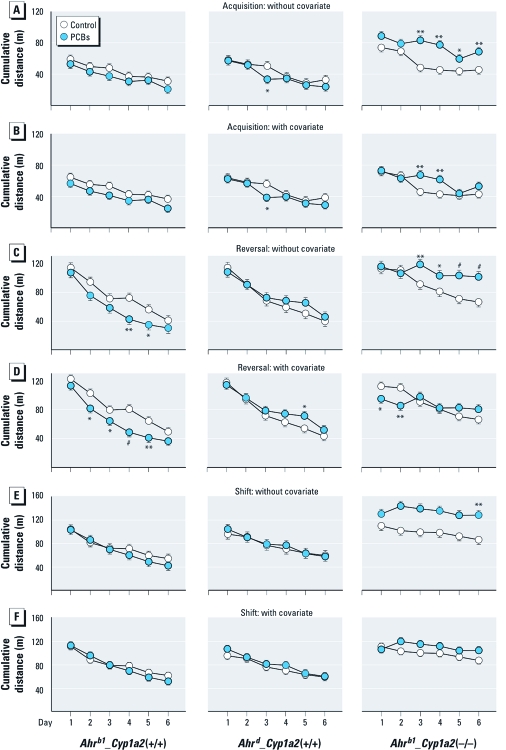
Results of MWM (hidden) test presented as cumulative distance to the platform (mean ± SE). During each phase there were genotype × treatment effects on speed (all p < 0.01); therefore, data were analyzed using without (A,C,E) and with (B,D,F) speed as covariates. (A and B) Acquisition (southwest platform). (C and D) Reversal (northeast platform). (E and F) Shift (northwest platform). See Supplemental Material, Table S2 (http://dx.doi.org/10.1289/ehp.1002965). *p < 0.05, **p < 0.01, and #p < 0.001 compared with control.